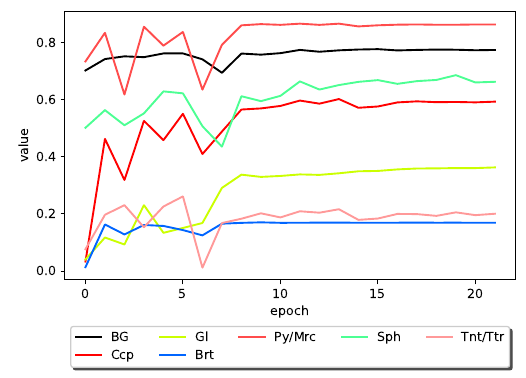
Figure 3. Per-class IoU metric for test subset of LumenStone S1 for all minerals (classes) over epoch.